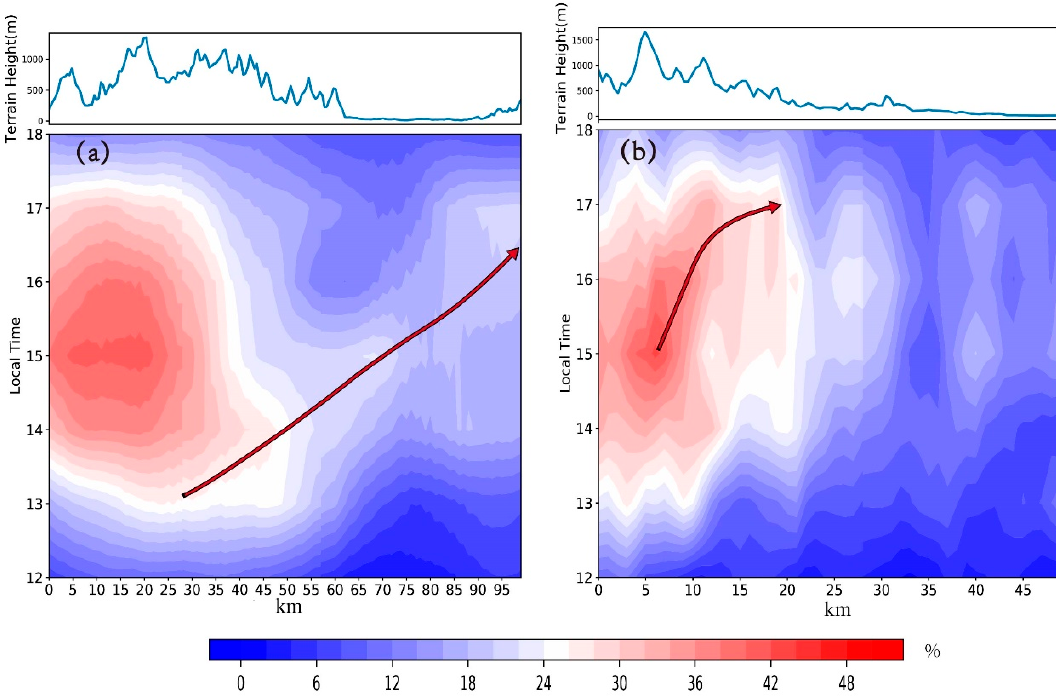
Figure 6. Hovmöller diagrams of the frequency of occurrence (%) of reflectivity ≥ 40 dBZ for subdomains ( a ) N box and ( b ) S box. The frequency is averaged along the short (long) side of subdomain N (S) box, as indicated in Figure 5c. The average topographic profile is also indicated at the top of each panel.